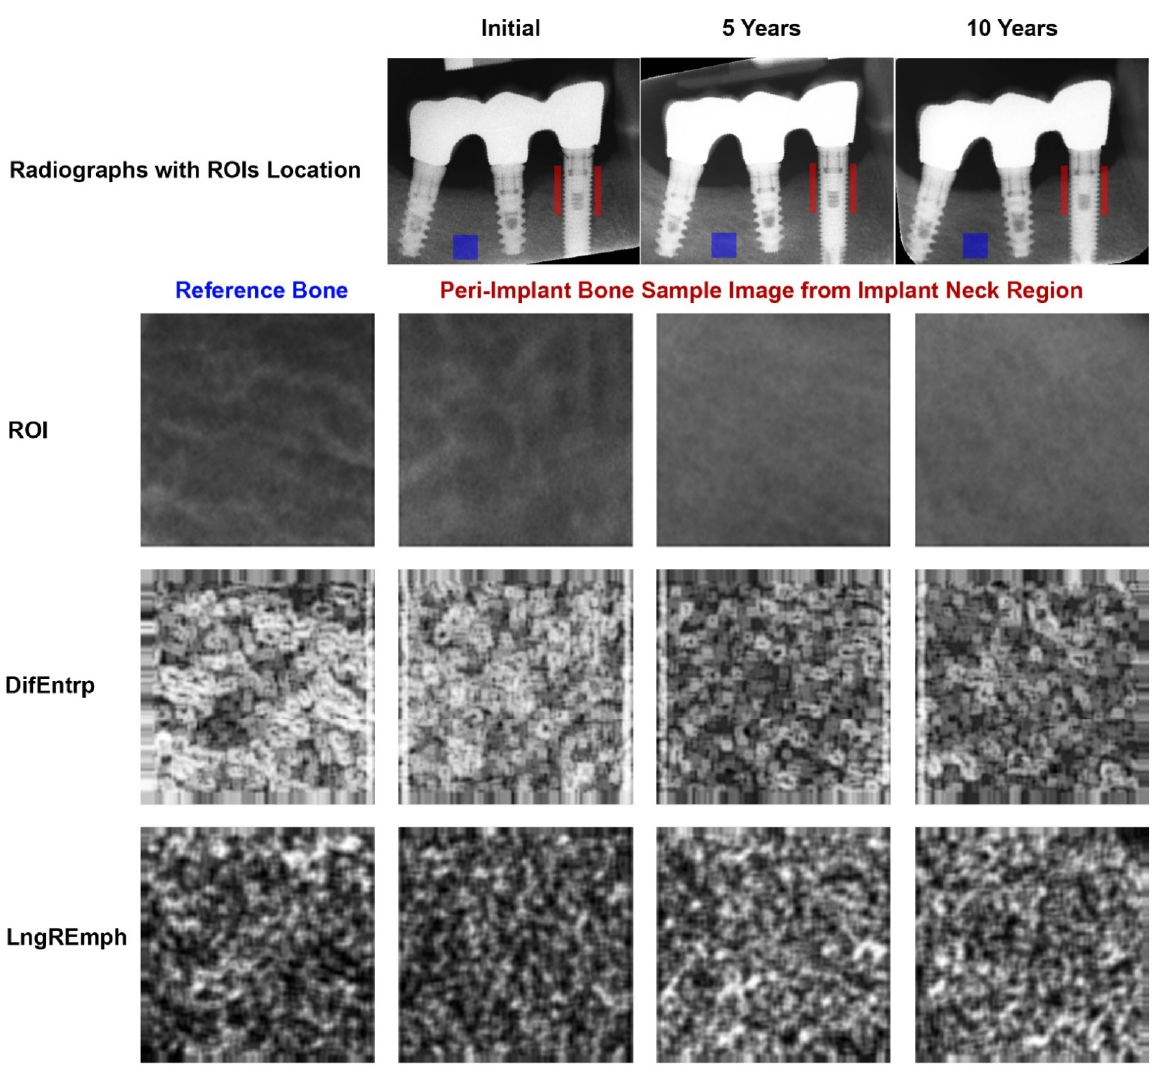
Figure 2. Demonstration of how digital texture analysis was performed on collected radiological material. The column under Initial contains images from the first period of the study, i.e., 3 months after implant insertion, on the day prosthetic work was performed. The next column titled 5 Years contains images from when the implants had been functionally loaded for 5 years. The last column on the right, named 10 Years, contains images from the last examination period, i.e., when the implants had been functionally loaded for 10 years. The top row shows radiographs in a chronological manner. The locations where the data were taken for analysis, i.e., regions of interest (ROIs), are shown here. The ROI of the reference cancellous bone is circled in blue. Two further ROIs (red) are located as close as possible to the dental implants and start at the implant neck and extend 5 mm into the bone. For calculations, data from these two ROIs were combined so that the area of the image sample from the implant neck region was equal to the area of the reference ROI. The second row from the top shows the image samples (ROIs) that were analyzed below (these are still radiological images). The third row from the top shows maps of image texture feature intensity: DifEntrp, from the reference area, through peri-implant at baseline, then after five years of implant loading, and rightmost after 10 years of loading. The whiter areas represent structures with higher entropy (more chaotic structural pattern), and the blacker areas show places where entropy is lower (more regular, homologous structural pattern). The lowest, fourth row of images shows intensity maps of the texture feature: LngREmph. The white areas have more very long structures, while the black areas have few long